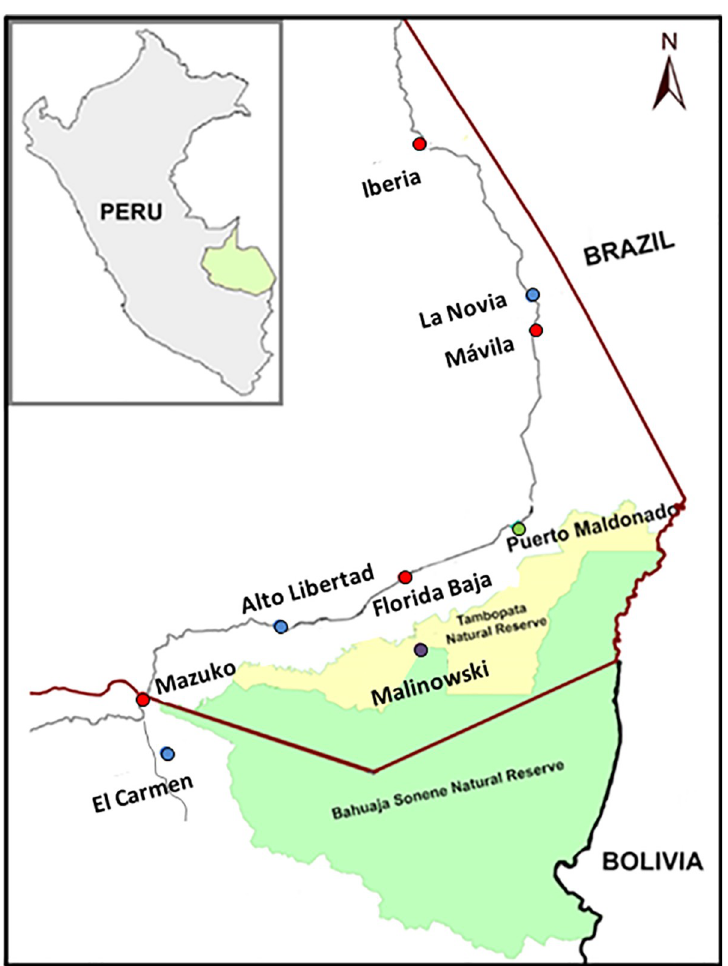
Fig 1. Map of the study area. Figure illustrates the Peru, Brazil and Bolivia border, highlighting Madre de Dios state (Peru) crossed by the interoceanic highway. Study sites are coloured depending on the degree of human impact in red (high impact), blue (low impact) and purple (undisturbed) circles, while the state capital (Puerto Maldonado) is in green. The map was created using open data obtained from OpenStreetMap (CC BY-SA 2.0) URL: https://www.